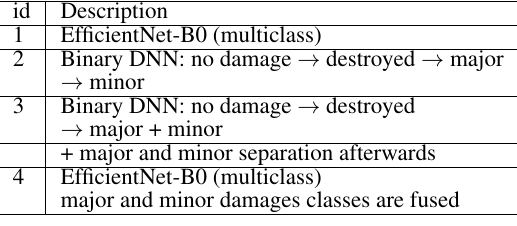
Table 4. Description of fusion policies